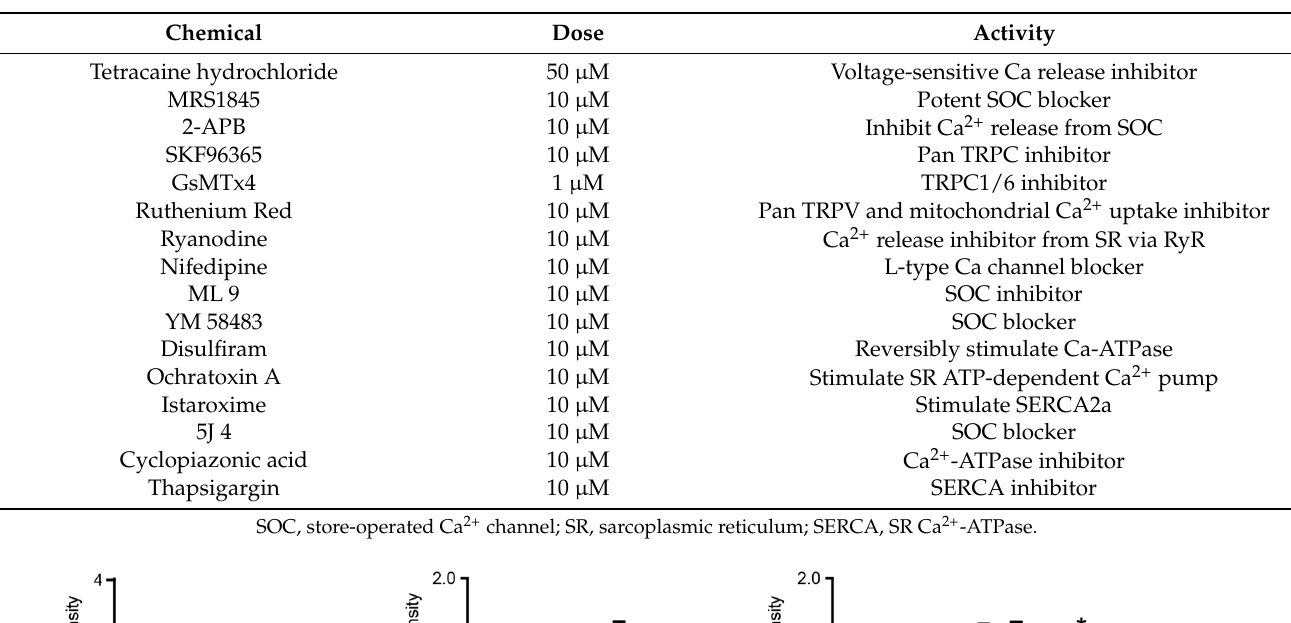
Table 1. A list of chemicals used in the Ca 2+ mobilization assay.